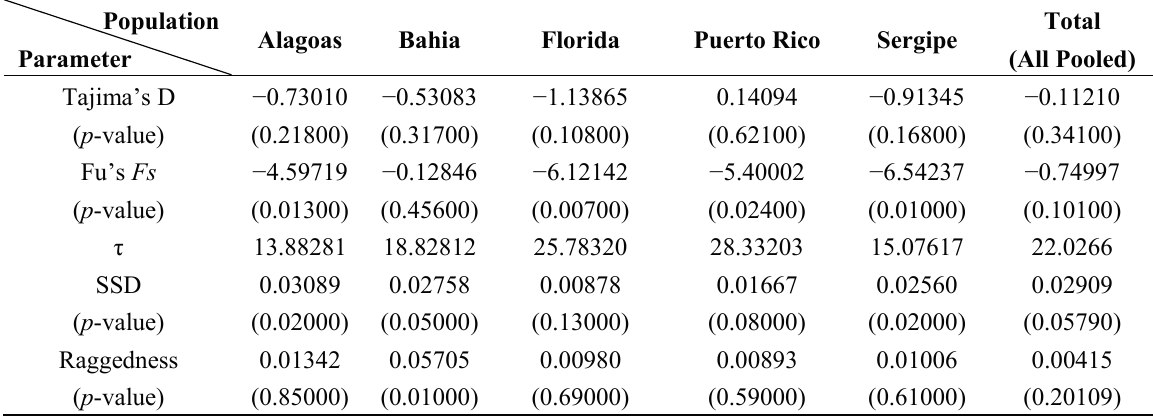
Table 4. Statistical tests for neutrality and the estimate of demographic parameters